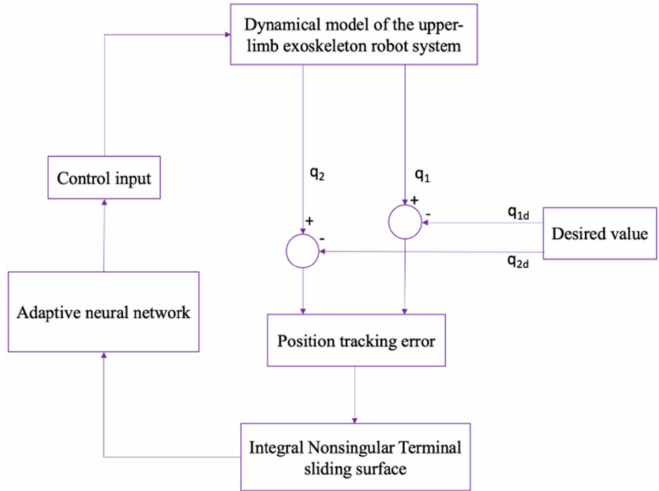
Figure 3. Block diagram of the proposed